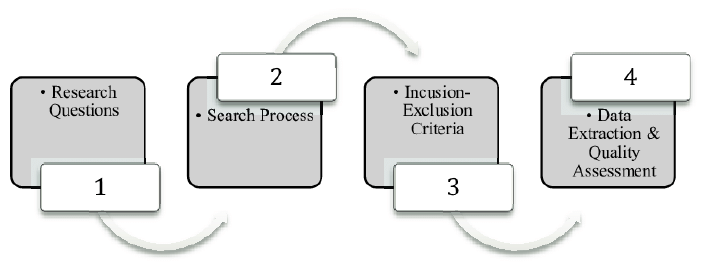
Figure 3. Steps of a traditional SLR